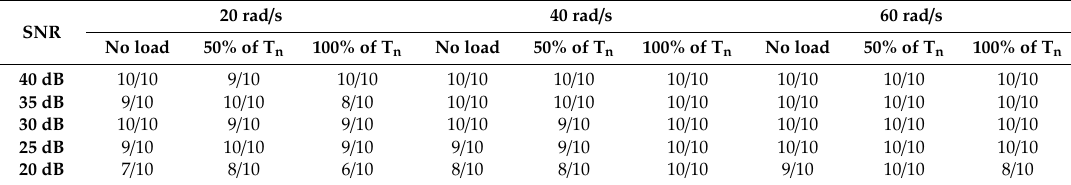
Table 4. CUSUM variance detection performances for kurtosis signal with P D >